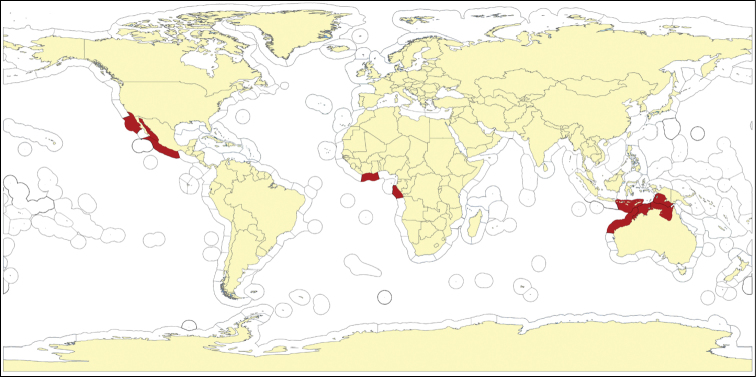
Idealized global distribution of the genus Trikentrion, showing presence of the genus in Marine Ecoregions of the World (Spalding et al. 2007).